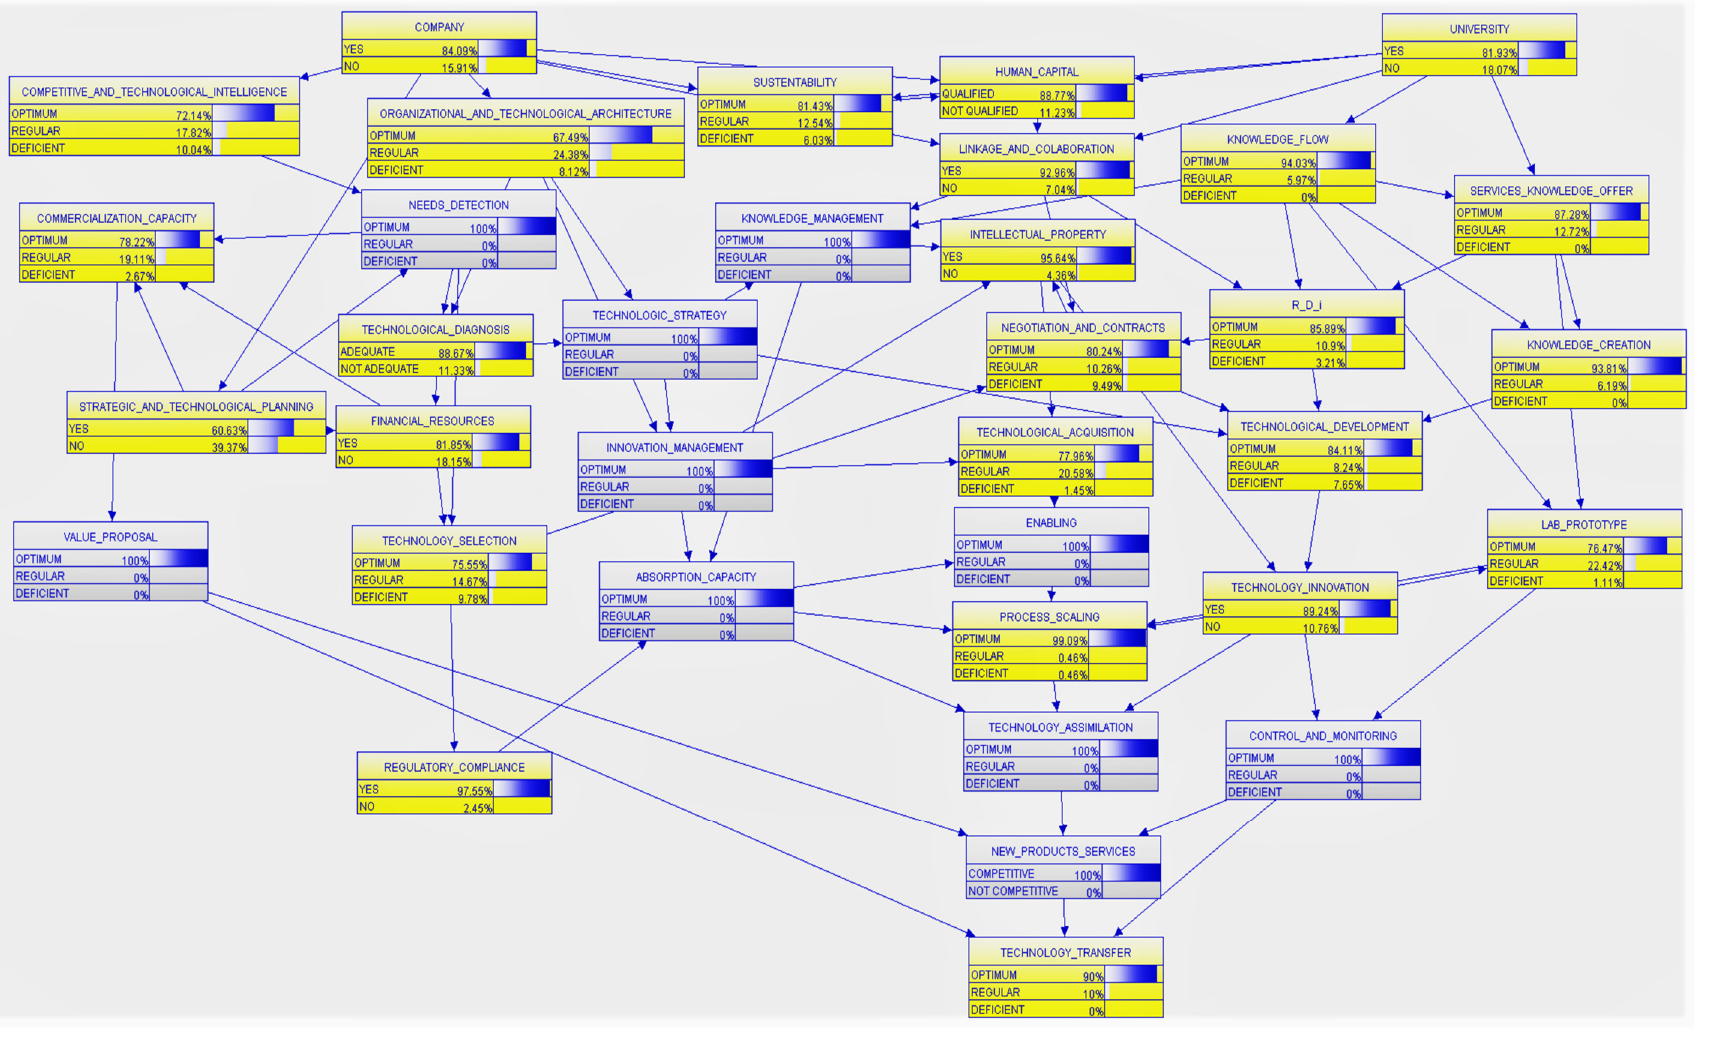
Figure 2. Bayesian network.